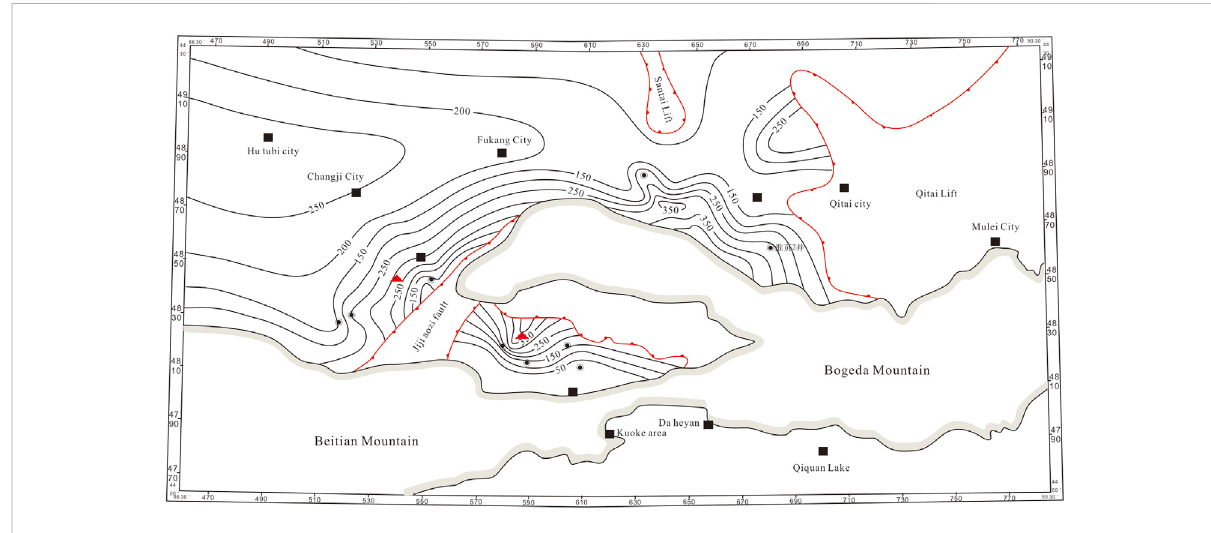
FIGURE 1 Study area, location, columnar drilling, and sampling